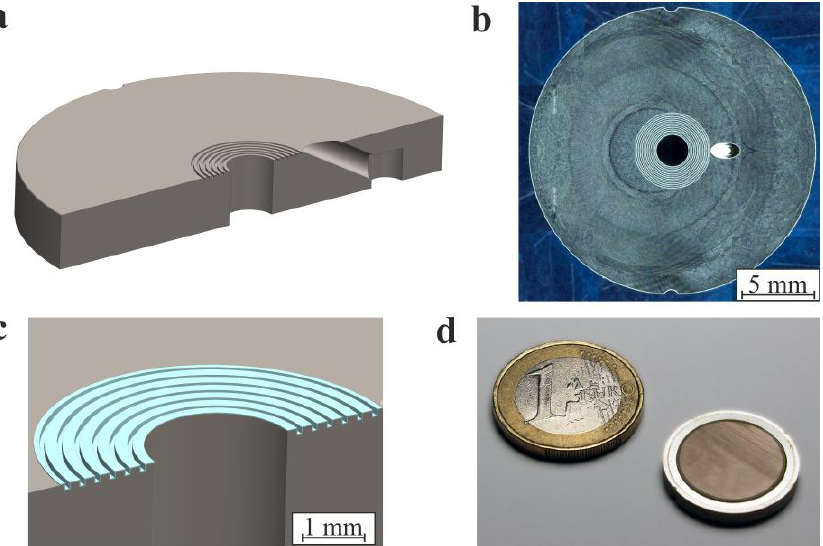
Figure 2. ( a ) Model of the NO valve body incorporating two fluid ports and micromachined trenches. ( b ) Light microscope picture of the micromachined valve steel body. ( c ) Model of the valve seat coated with Parylene-C. ( d ) Photograph of an assembled microvalve after laser welding and piezoelectric actuator bonding next to a Euro coin. The microvalve has a diameter of 20 mm and a height of 2.6 mm.